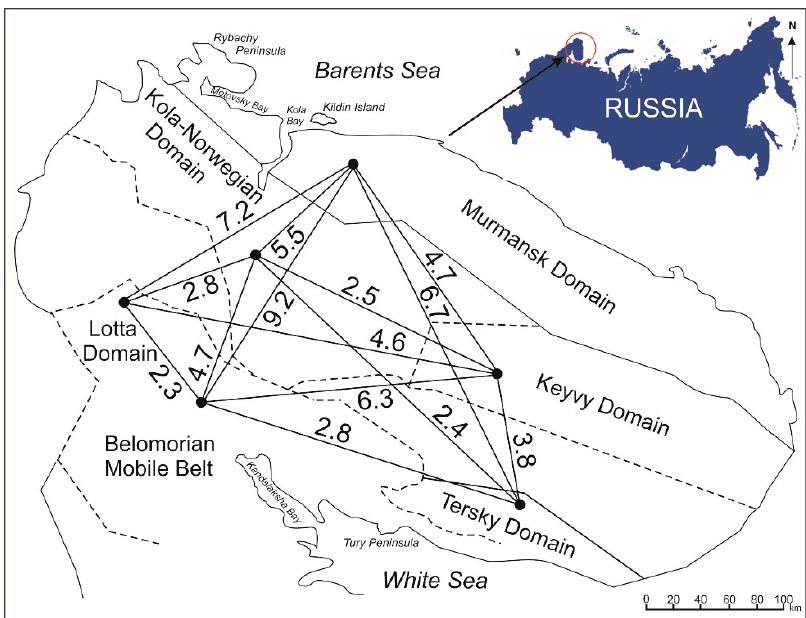
Figure 7. Compared mineralogical compositions of different Archaean structures in the Kola region. Structures are numbered as in Figure 3. Numbers near lines indicate a proximity coefficient of respective rock assemblages. The lower the coefficient of difference, the more the compared rock assemblages are similar.